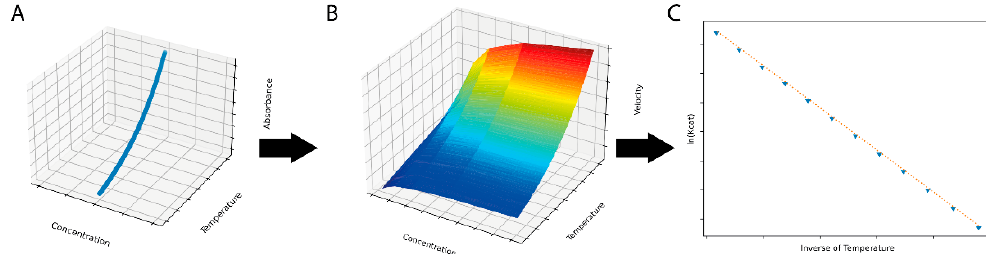
Figure 1. A simulated dataset ( A ) with individual observations generated by integrating the Arrhenius equation over time and temperature was used for input for the ThermoSlope software. The ThermoSlope software uses a rolling regression to estimate the velocities over temperature and time gradients ( B ) and determines the thermodynamic parameters of the activation barrier via the Arrhenius plot ( C ).